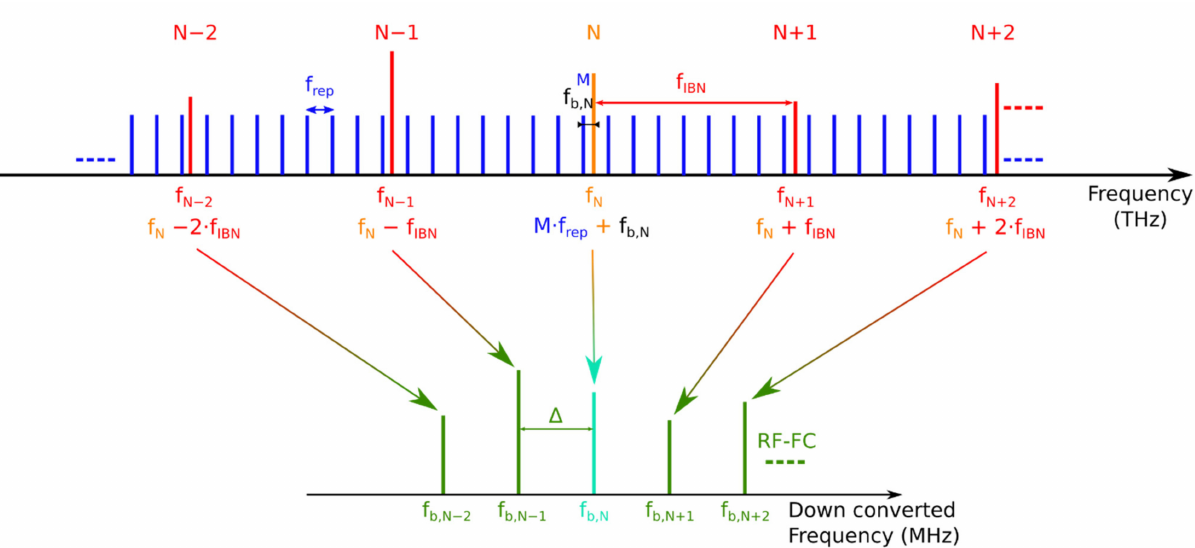
Figure 5. Illustration of the multi-heterodyne down-conversion process. Schematic representation of the quantum cascade laser (QCL-) (red) and optically rectified (OR-) frequency comb (FC) (blue), whose modes are respectively spaced by f IBN and f rep . These two repetition frequencies are tuned close to an integer ratio, allowing an ordered and distinguishable down-conversion to radio frequencies (RF). In fact, the down-converted RF-FC modes (green) are equally spaced by ∆ , and their easily measurable RF frequencies are used to calibrate the absolute frequency scale of the QCL-FC, as described in the main text. Reprint with permission from [36] Copyright Communications